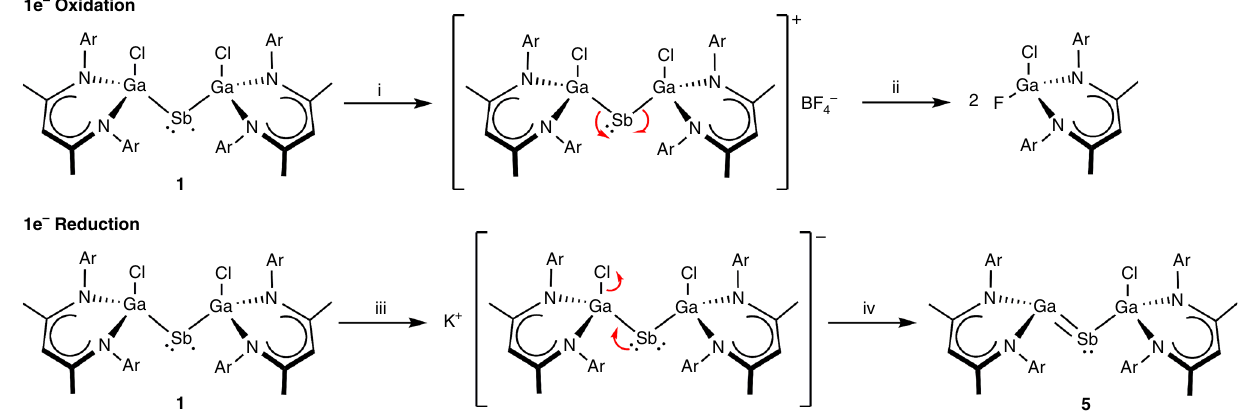
Fig. 6 Single-electron oxidation and reduction reactions of 1 . i sonicating 1 and 1 eq. of NO[BF 4 ] in benzene at 25 °C, followed ( ii ) by addition of a 2nd eq. of NO[BF 4 ] in benzene at 25 °C; iii reaction of 1 with 1 eq. of KC 8 in benzene at 25 °C over 1 h occurred with ( iv ) elimination of KCl